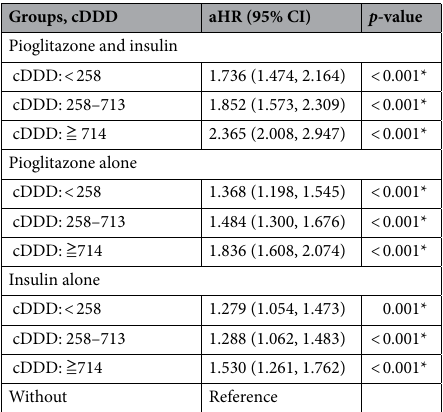
Table 3. Factors of AD among different cDDD by Cox regression with/without Fine and Gray’s competing risk model (n = 31,422). AD, Alzheimer’s disease; cDDD, cumulative defined daily dose; aHR, adjusted hazard ratio (adjusted for the variables listed in Table 2); CI, confidence interval. * p < 0.05.